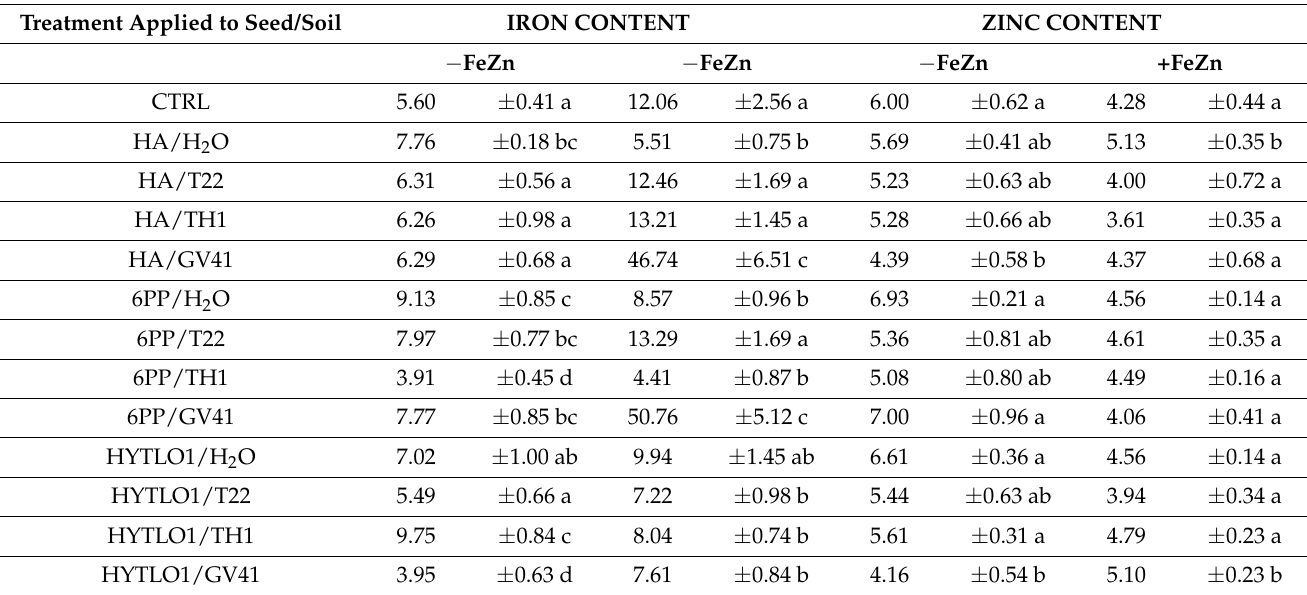
Table 6. Effects of combined treatments with Trichoderma strains (T22, TH1, GV41) or metabolites (HA, 6PP, HYTLO1) on the lentil mineral content. Water treatments served as controls (CTRL). Treatments were applied to the seed (indicated on the left), then to the soil (indicated on the right). After 7 d from the soil treatment, another soil watering was carried out using the 1X FeZn solution (+FeZn) or water ( − FeZn). Data represent the mean value of three biological replicates ± standard deviation (SD). Different letters in a column indicate statistically significant differences for p < 0.05. Mineral Content (mg/100 g Sample)